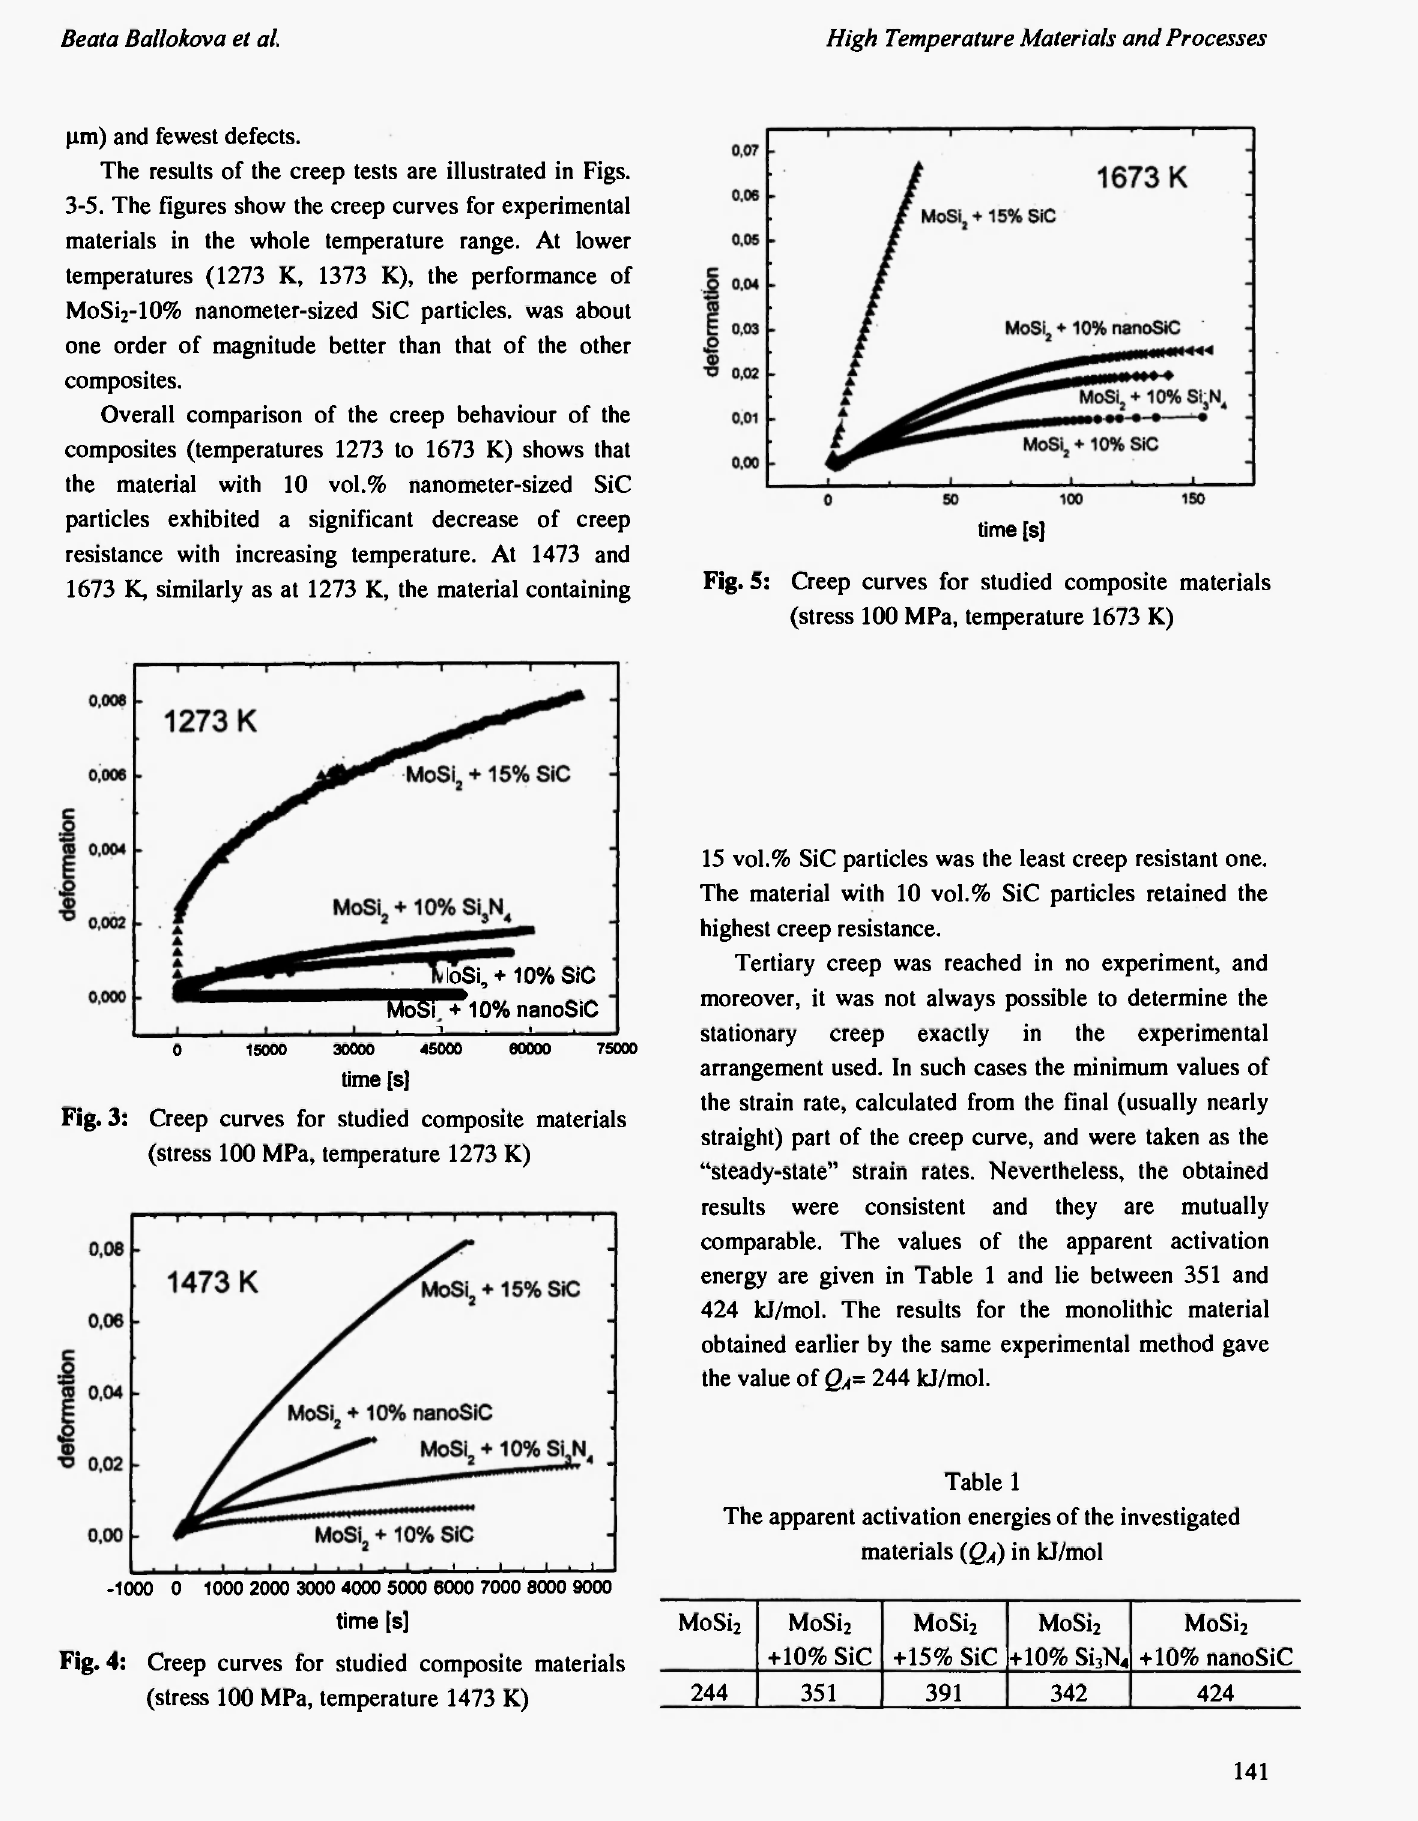
Fig. 4: Creep curves for studied composite materials (stress 100 MPa, temperature 1473 K)